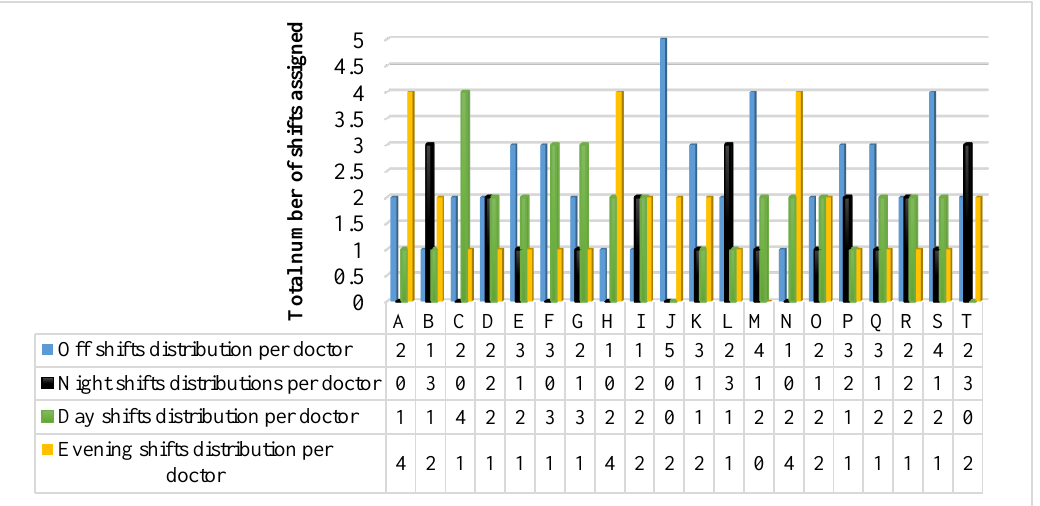
Figure 4. Distribution of Shifts for One Week.